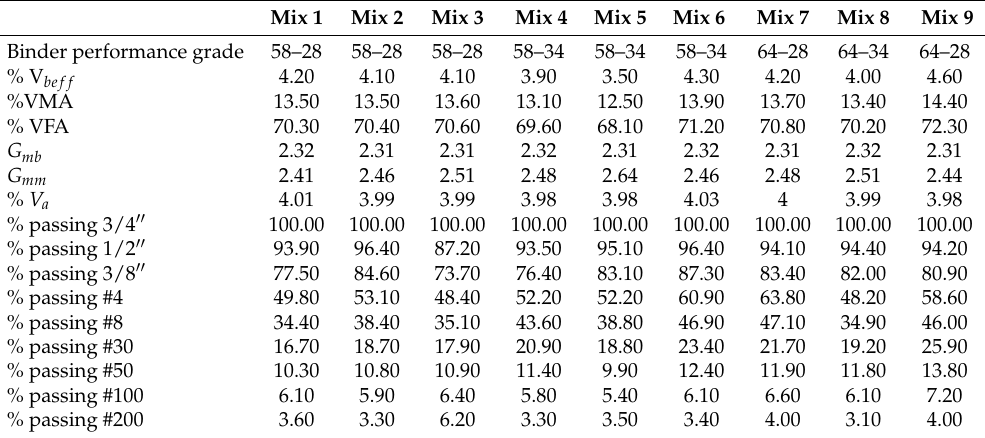
Table 1. General Mixture Properties of Nine Asphalt Mixtures Used in this